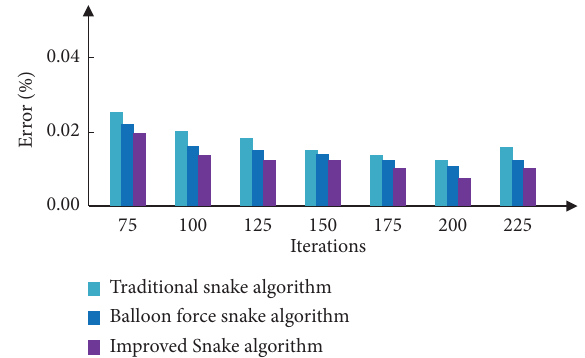
Figure 10: Error of solution under diferent